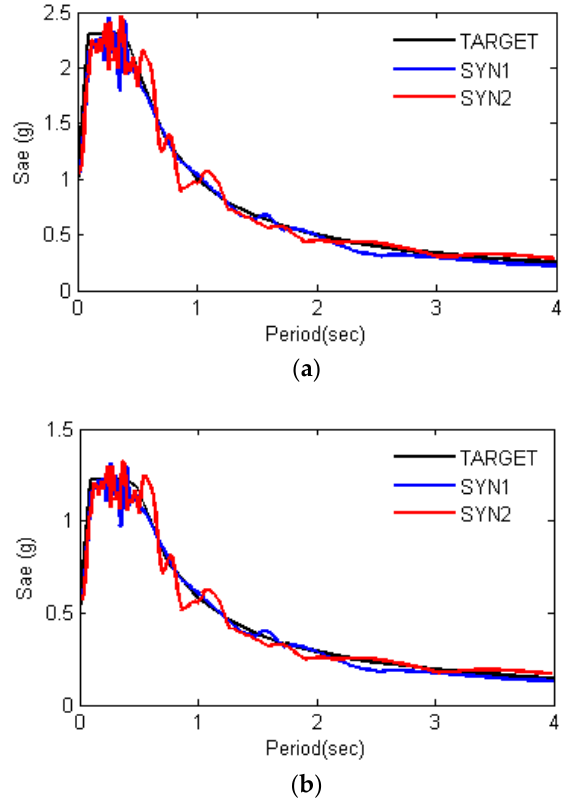
Figure 7. ( a ) Comparison of target response spectrum for ground motion level 1 with corresponding synthetic earthquake; ( b ) Comparison of target response spectrum for ground motion level 2 with corresponding synthetic earthquake.